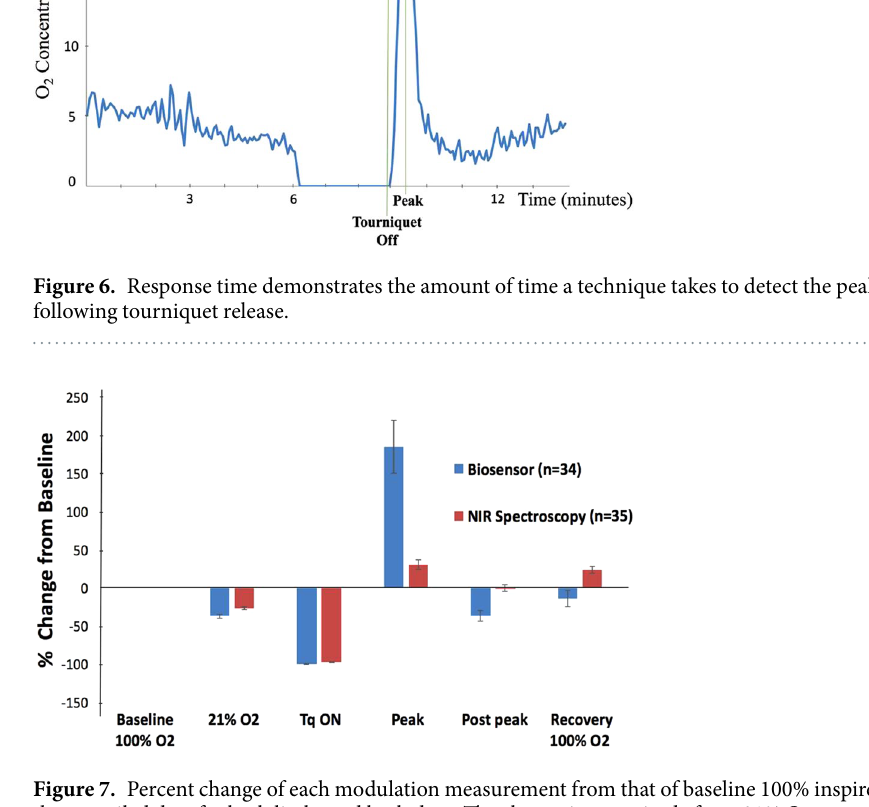
Figure 7. Percent change of each modulation measurement from that of baseline 100% inspired O 2 . Shown are the compiled data for both limbs and both days. The change in magnitude from 21% O 2 to reactive hyperoxia peak is significantly more pronounced for biosensor as compared to NIR spectroscopy. (p =